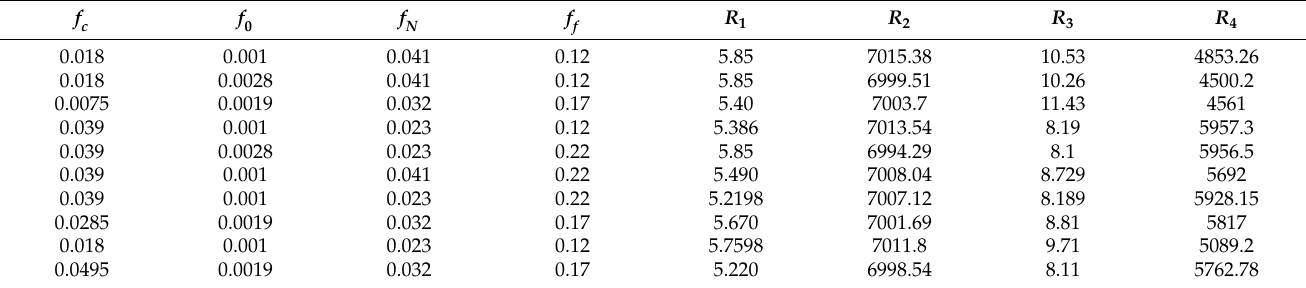
Table 5. Design scheme of damage parameters and response